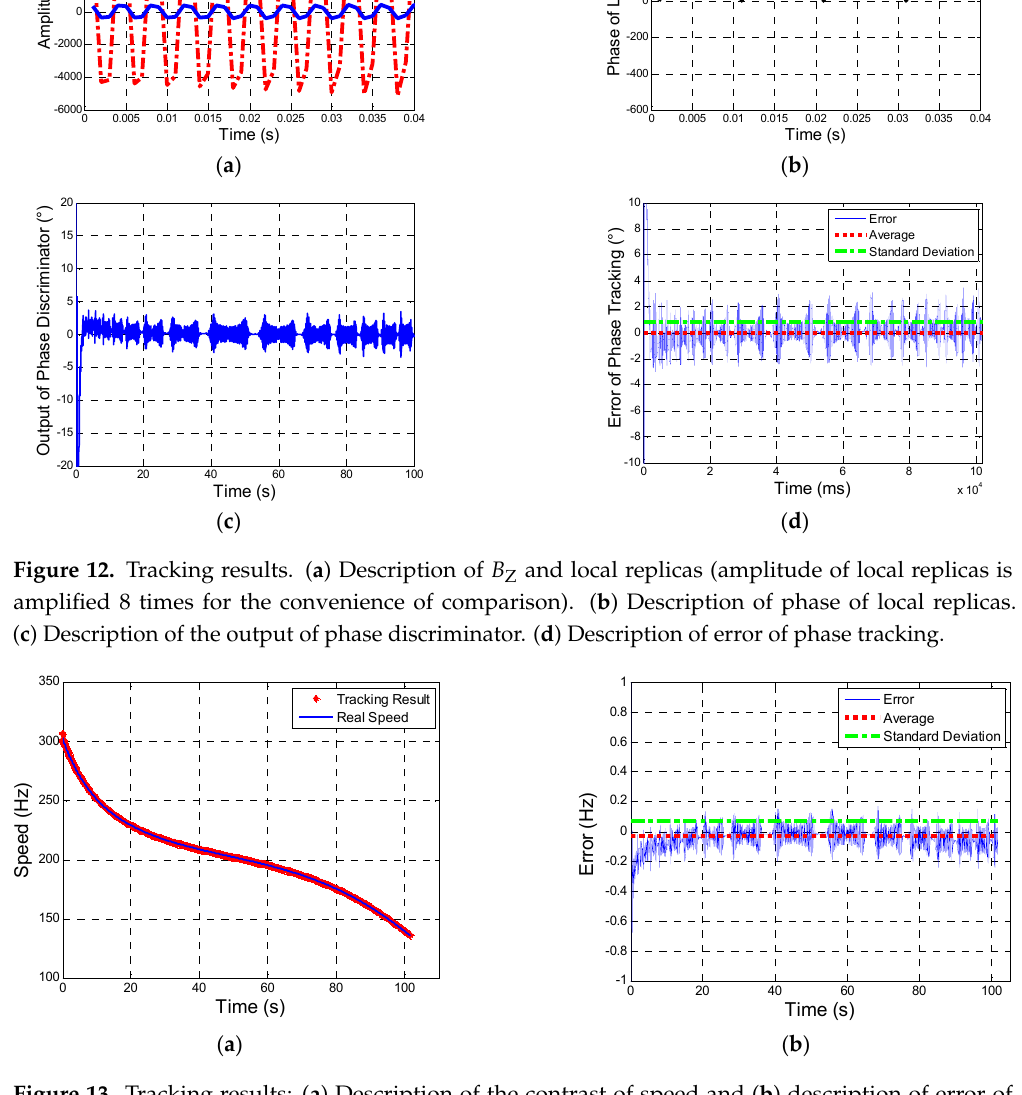
Figure 13. Tracking results: ( a ) Description of the contrast of speed and ( b ) description of error of speed tracking.